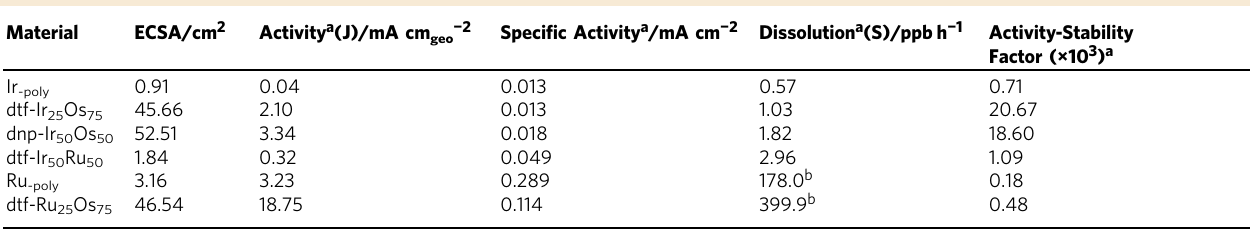
Table 1 Catalytic properties of relevant metal oxide materials for OER